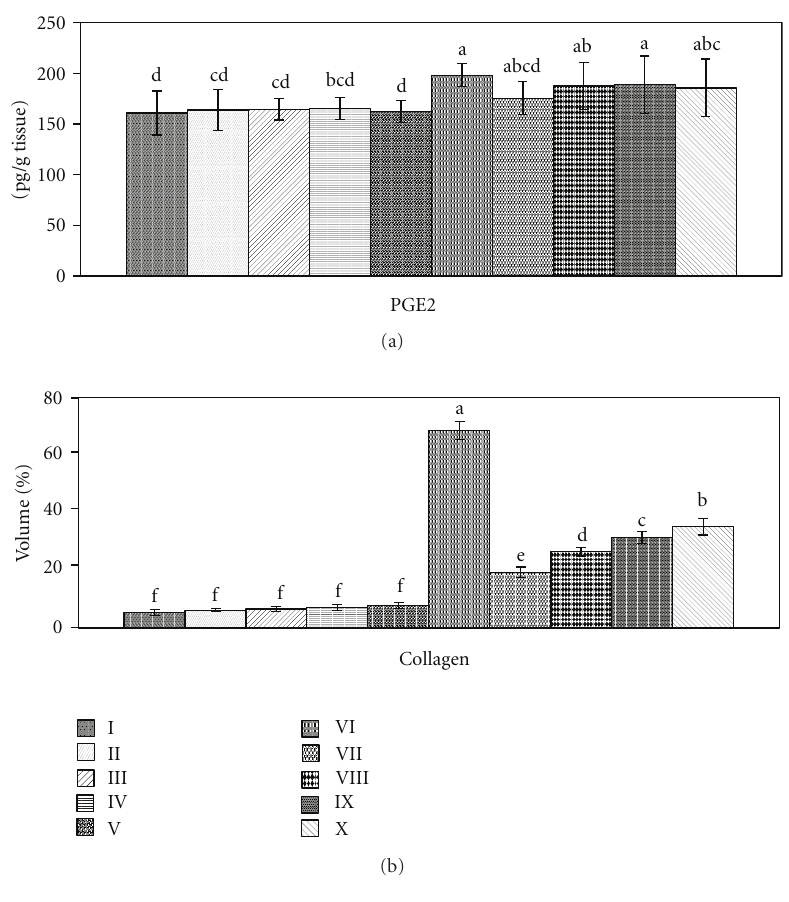
Figure 3: E ff ect of Zingiber o ffi cinale on prostaglandin E 2 (PGE 2 ) and collagen percentage. Groups I: control, II: control treated with ethanol extract, III: control treated with chloroform extract, IV: control treated with petroleum ether extract, V: control treated with silymarin, V1: intoxicated with CCl 4 , VII: intoxicated with CCl 4 and treated with ethanol extract, VIII: intoxicated with CCl 4 and treated with chloroform extract, IX: intoxicated with CCl 4 and treated with petroleum ether extract, and X: intoxicated with CCl 4 , treated with silymarin. Data of PGE 2 are mean ± SD of six rats in each group. Collagen percentages are mean of ten fields of collagen deposition under light microscope (100x). Statistical analysis is carried out by one-way analysis of variance (ANOVA); Costat Computer Program. Unshared letters are significance values between groups at P < 0 .